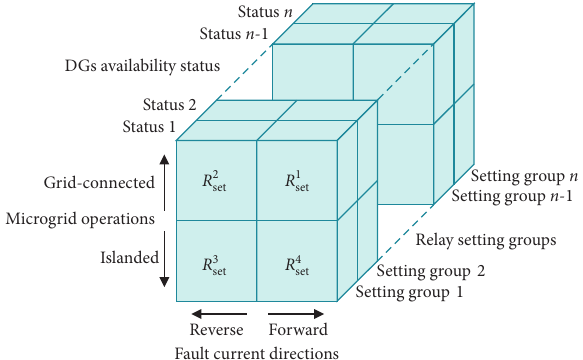
Figure 8: Set of relay setting groups for each